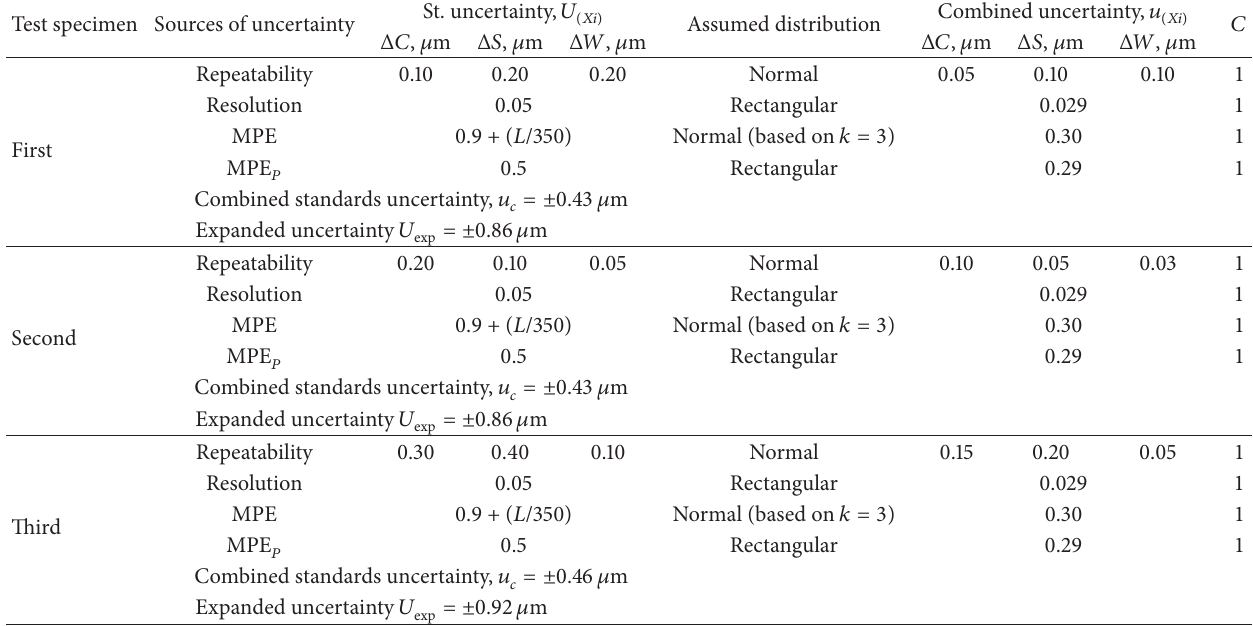
Table 11: Estimation of uncertainty budget in straightness deviation for tiles